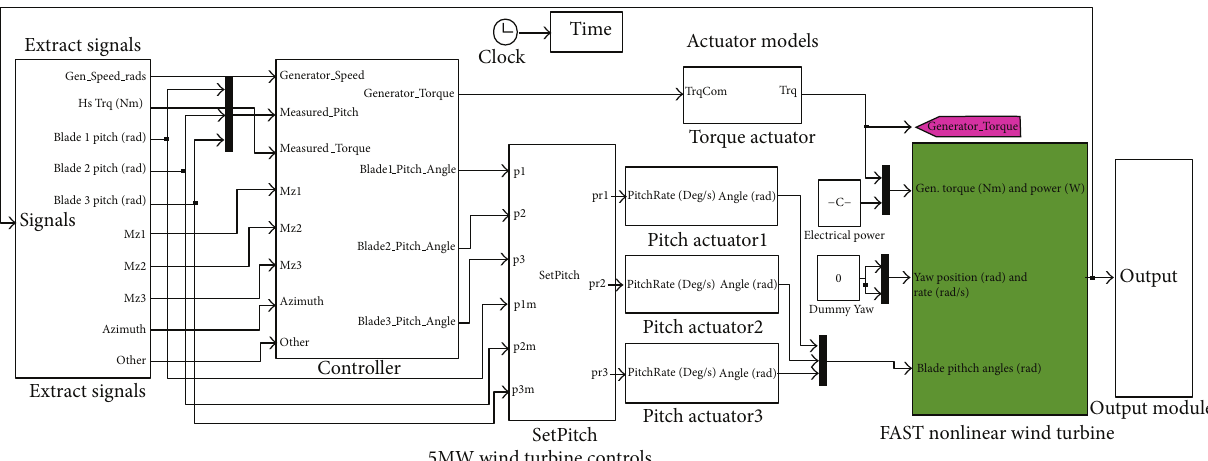
Figure 5: Overall simulation module of the controller